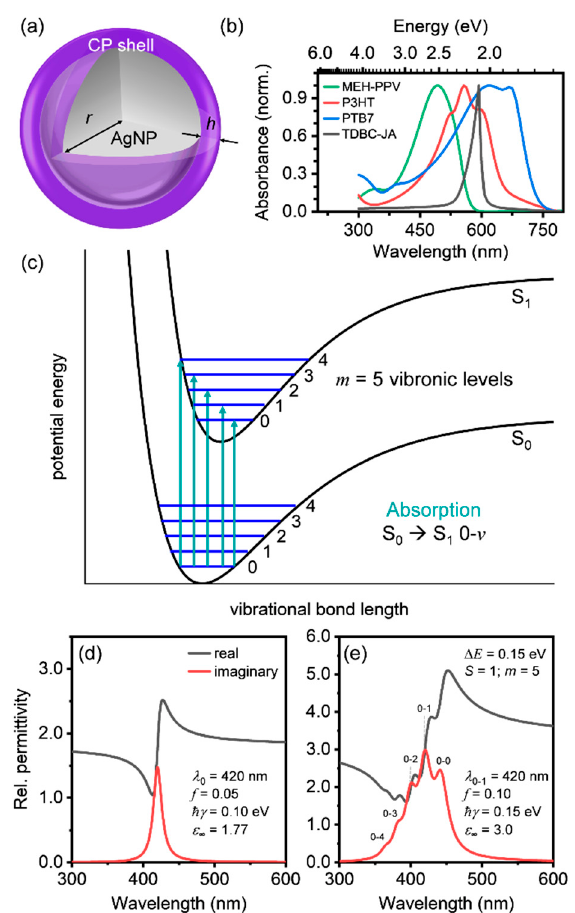
Figure 1. ( a ) Core-shell nanoparticle structure used to investigate coupling between excitons in conjugated polymers (CPs) and localized surface plasmon resonances (LSPRs). The silver nanoparticle (AgNP) core radius is given by r , and the CP shell thickness is given by h . ( b ) Normalized absorption coefficient of various conjugated polymers (MEH-PPV, P3HT, and PTB7) and a typical cyanine dye J -aggregate (TDBC-JA; see abbreviations section for full names of polymers and dye). ( c ) Schematic of potential energy curves of a simple anharmonic oscillator in the ground ( S 0 ) and excited ( S 1 ) states as functions of the bond length. The solid blue lines (0,1,2,...) represent the vibrational energy levels ( v ) associated with each electronic energy level. Absorption transitions are shown as vertical lines from S 0 → S 1 0- v . ( d ) Real and imaginary parts of the relative permittivity for a single Lorentzian oscillator used as the basis for modeling J -aggregate optical properties. ( e ) Real and imaginary parts of the relative permittivity for a model conjugated polymer comprised of m = 5 oscillators. Symbols used: 0- v = absorption transition from S 0 → S 1 , into the v th vibrational level; λ 0 = resonance wavelength; λ 0-1 = resonance wavelength for 0-1 transition; f = oscillator strength; ħγ = resonance linewidth; ε ∞ = high-frequency relative permittivity; Δ E = spacing between oscillators; S = Huang-Rhys factor.